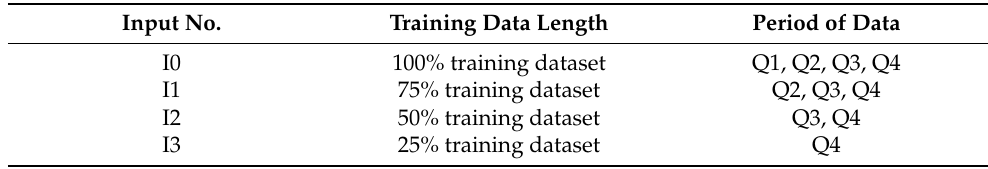
Table 6. Composition of different training data.